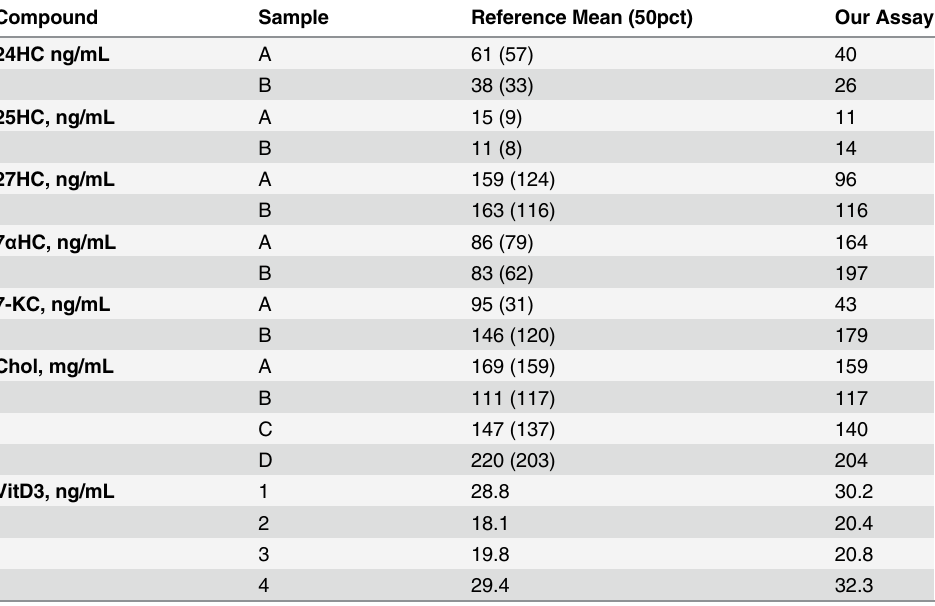
Table 3. Comparison of the assay to external reference materials. Compound